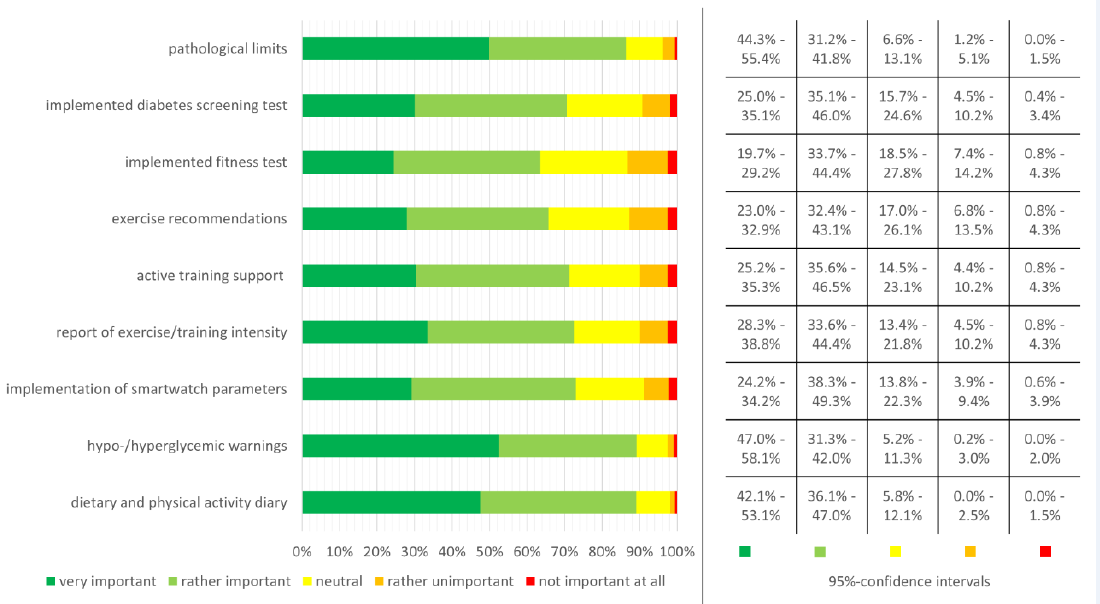
Figure 3. Importance of potential functions and features included in the ELSAH-patch software. Corresponding 95%-CIs are shown on the right side of the figure.